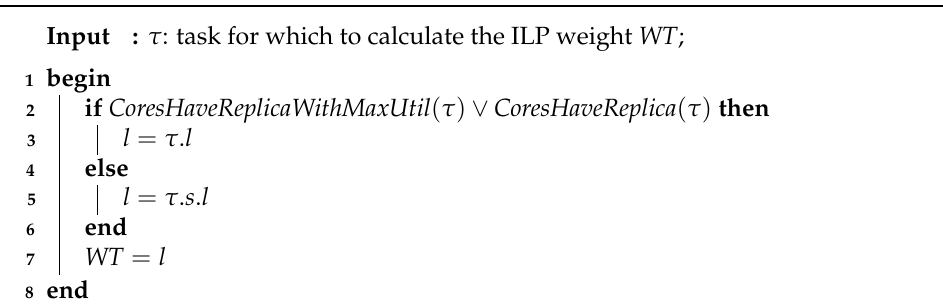
Algorithm 2: Calc-CA-aware